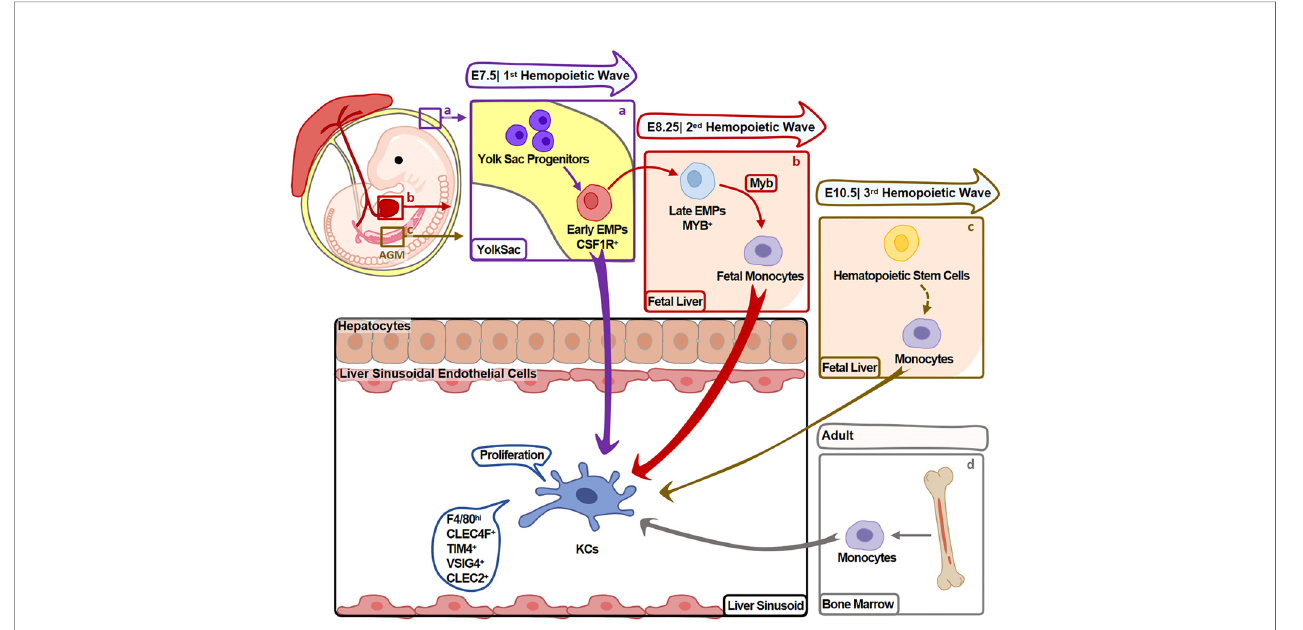
FIGURE 1 | Heterogeneity of KC Origin. KCs mainly develop during hemopoiesis. (A) In the fi rst hemopoietic wave (around E7.5), YS-macrophages are differentiated from EMPs in YS without experiencing monocyte stage. Partial YS-macrophages then migrate and reside in fetal liver, further specialize into KCs. (B) In the second hemopoietic wave (around E8.25), late EMPs differentiate into KCs undergo a monocytic intermediate in fetal liver. (C) In the third hemopoietic wave (around E10.5), hematopoietic stem cells originate from the aorta-gonads-mesonephros (AGM) region and migrate to fetal liver. They give rise to monocytes that differentiate into KCs during perinatal period. KCs developed in this process contribute minor to adult KCs. (D) Fourthly, in adults, BM monocytes also give rise to minor KCs. Arrow width represents the contribution of relative progenitors to